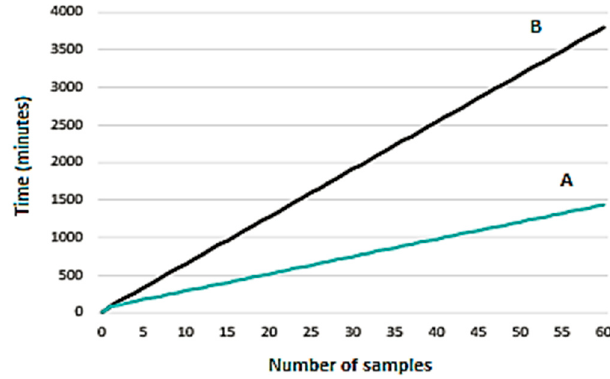
Figure 2. Comparison between solid-phase microextraction fast fit fiber assemblies (SPME-FFA) Multi Off-Line Sampler ( A ) and SPME on-line ( B ) for the analysis of 60 urinary OH-PAHs samples. To show the above findings the authors present the final results in Table 2. Table 2. Limits of detection (LOD), limit of quantification (LOQ), accuracy and precision for each OH-PAH measured in urine samples.